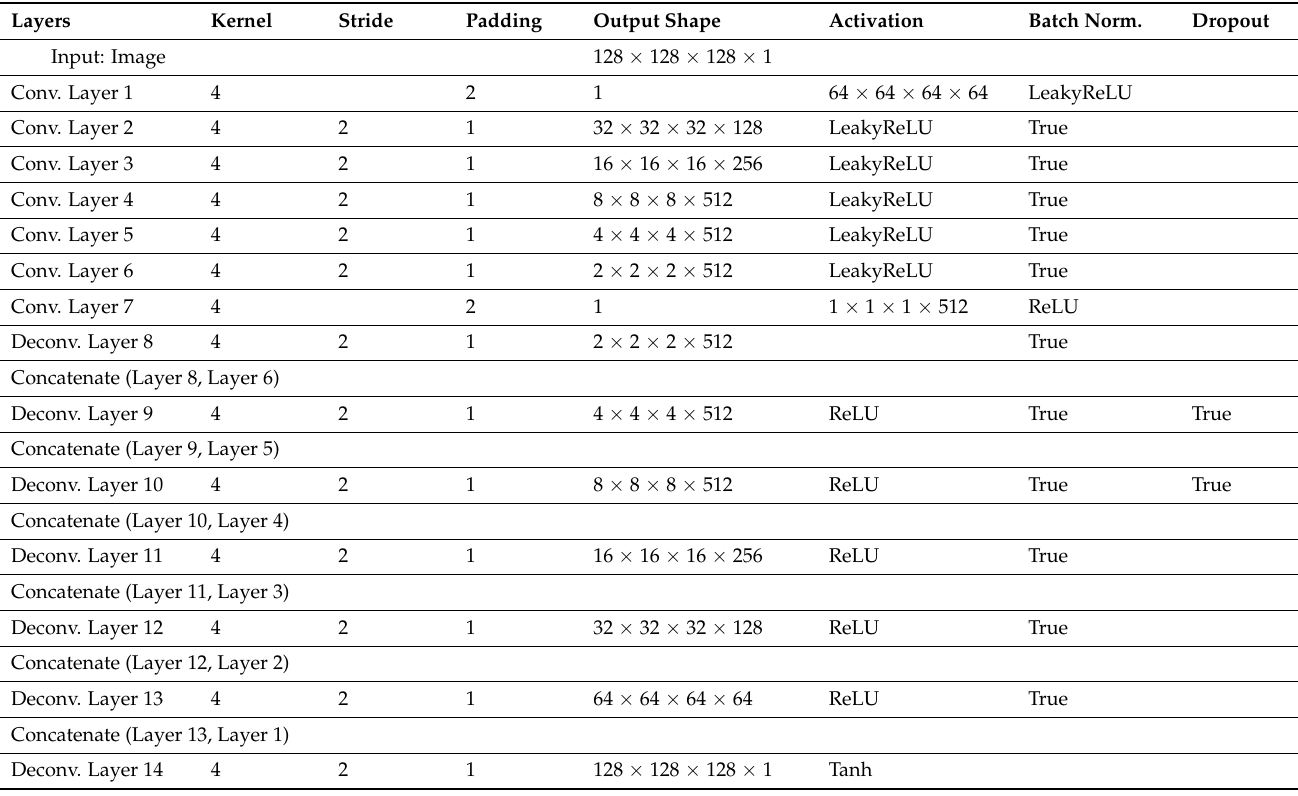
Table A1. Detailed architecture of the generator network of the 3D GAN in Figure 1b.